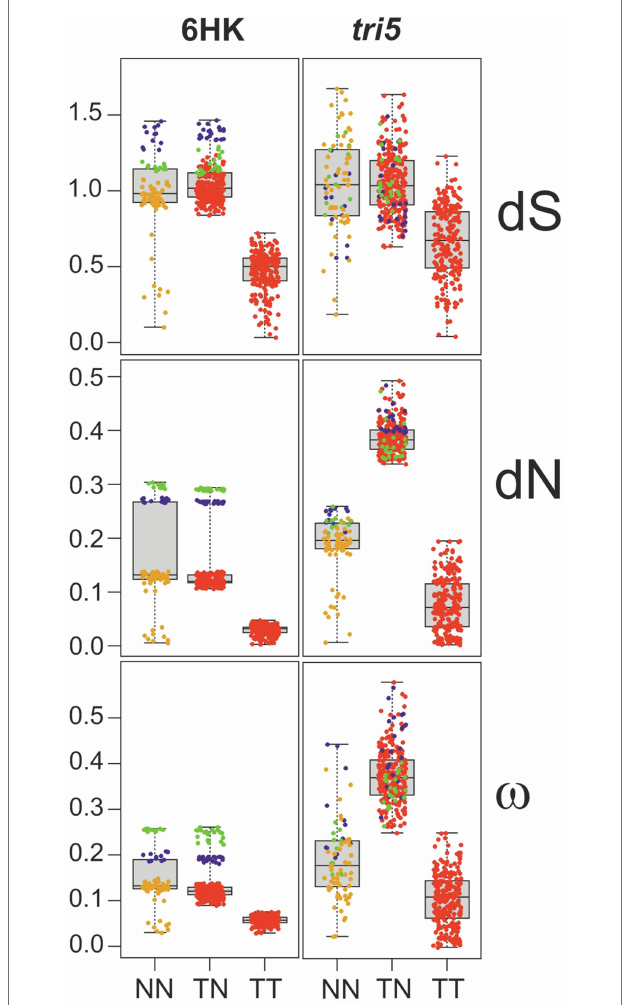
FIGURE 5 | Boxplots and scatterplots of the distances between sequence pairs. The pairs analyzed were between non- Trichoderma (NN), Trichoderma and non- Trichoderma (TN), and Trichoderma (TT) genes. The distances of nonsynonymous changes per nonsynonymous site (dN); synonymous changes per synonymous site (dS), and the dN/dS ratio ( ω ) are included. The trees inferred from tri5 and from concatenated alignments of six housekeeping genes (6HK) were considered in this analysis. Green and blue dots in the scatterplots indicate comparisons involving Aspergillus hancockii or Microscyclospora tardicrescens sequences, respectively. Red dots indicate comparisons involving all the other sequences. In the NN plot, however, orange dots indicate comparisons of non-Trichoderma species except for those that involve Aspergillus hancockii and Microcyclospora tardicrescens . Evidence for positive selection of tri5 : marked shift upward of dN values for Trichoderma vs. non- Trichoderma (TN) comparisons in the tri5 plot; this shift does not occur with dS values or in the 6HK